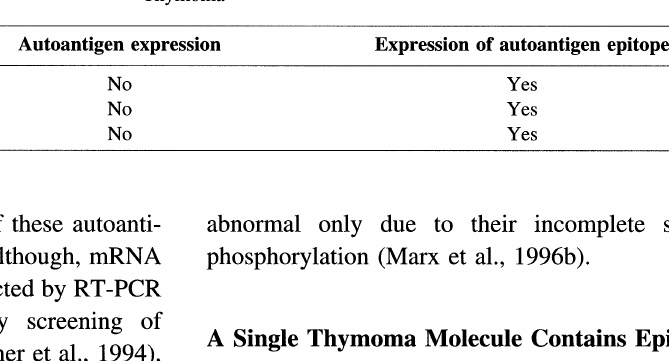
TABLE IV Expression of Autoantigen Epitopes but Not of the Main Antigens Themselves in Myasthenia Gravis-Associated